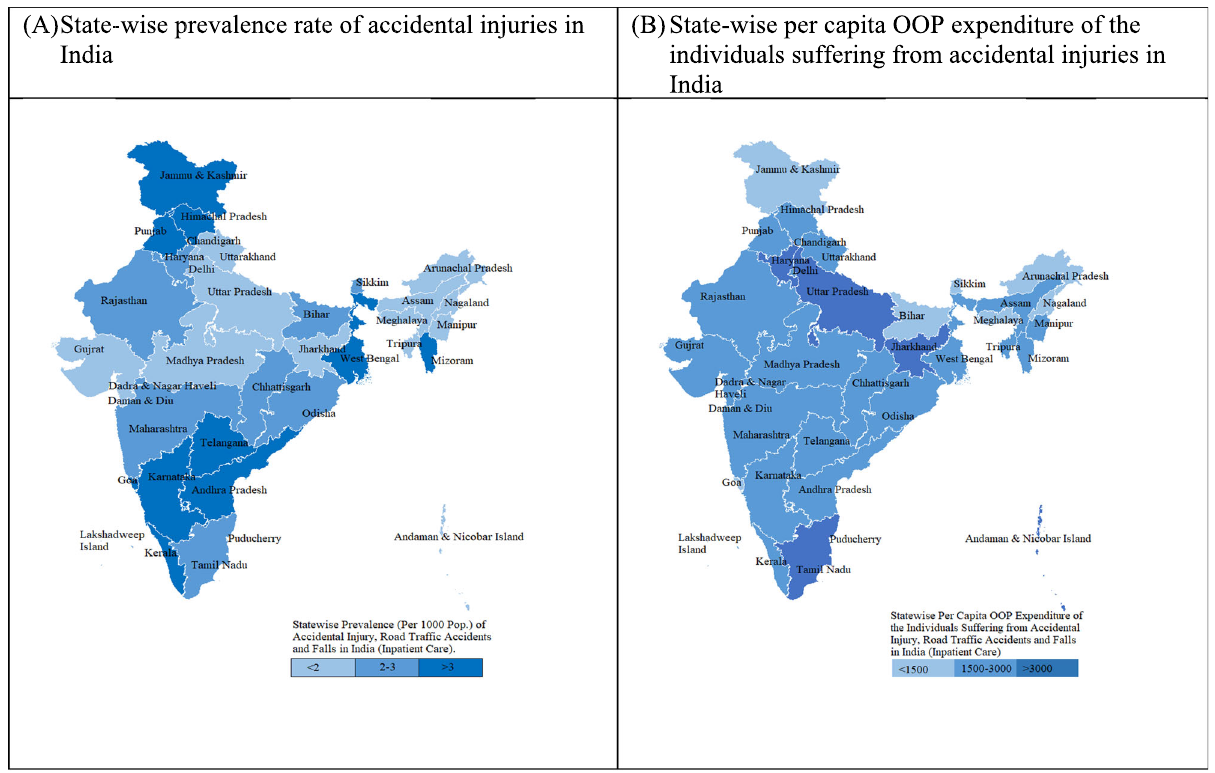
Fig. 1 Graphical illustration of state-wise prevalence rate of accidental injuries and per capita OOP expenditure of the individuals suffering from accidental injuries in India 2017 – 18 (Inpatient care). A State-wise prevalence rate of accidental injuries in India. B State-wise per capita OOP expenditure of the individuals suffering from accidental injuries in India. Figures are based on the author ’ s calculations from NSSO 75th